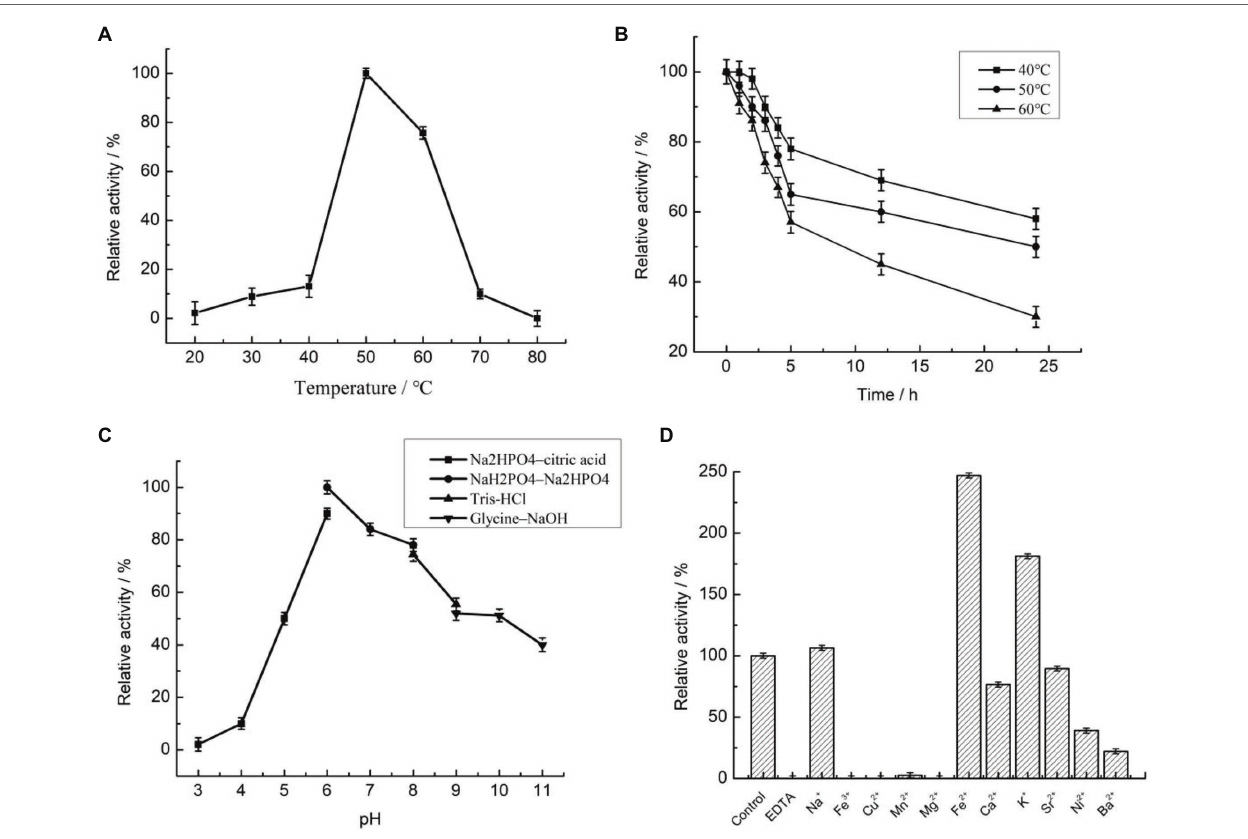
FIGURE 4 | Biochemical properties of purified recombinant Car1383 (see Materials and Methods for details of purification and standard assay procedure). (A) Effect of temperature on Car1383 activity. (B) Thermostability of recombinant Car1383 at different temperatures. (C) Effect of pH on Car1383 activity determined at 50 ° C using different buffer: Na 2 HPO 4 –citric acid (pH 3.0–6.0), Na 2 HPO 4 –NaH 2 PO 4 (pH 6.0–8.0), Tris–HCl (pH 8.0–9.0), or glycine–NaOH (pH 9.0–11.0). (D) Effects of metal salts (CaCl 2 , CuSO 4 ) and chelators on Car1383 activity.